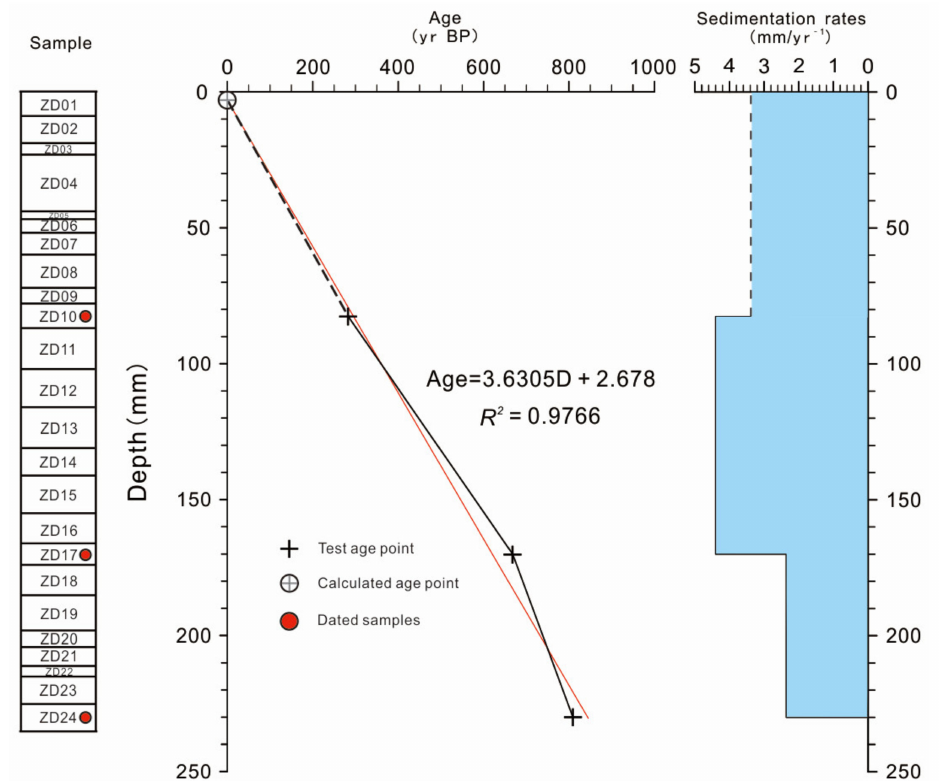
Figure 3. Age-depth profile based on U–Th dating from Zabuye Salt Lake travertine dam. The doted lines represent the value calculated using the age formula.